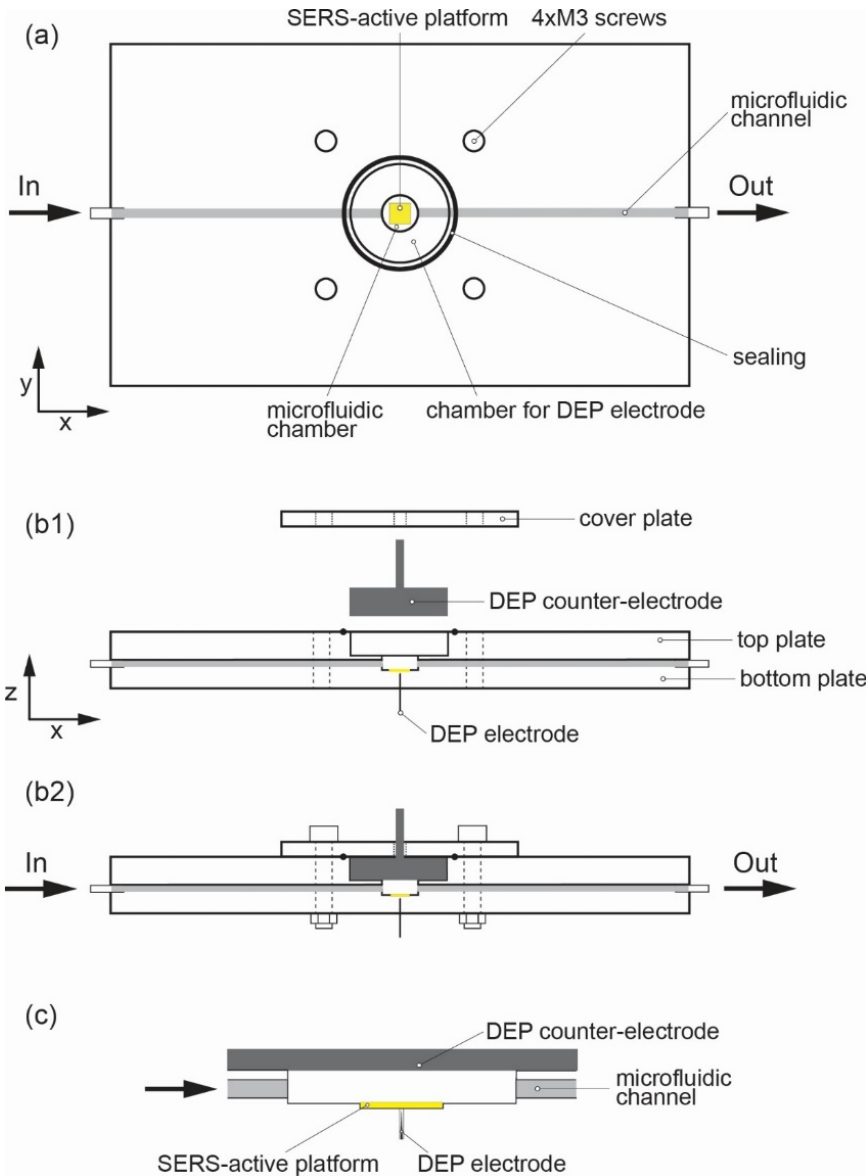
Figure 1. Schematic view of the microfluidic chip for the dielectrophoretic deposition of CTCs on the surface of the SERS platform ( a ), cross-section of the chip before assembly ( b1 ) and after placing cover plate on the top plate ( b2 ), detailed view of the microfluidic chamber with the DEP electrode under the SERS platform and counter-electrode at the top of the chamber ( c ).